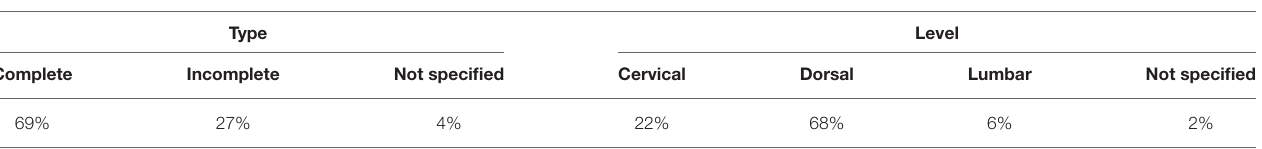
TABLE 1 | Occurrence of lesion based on type and level. Type